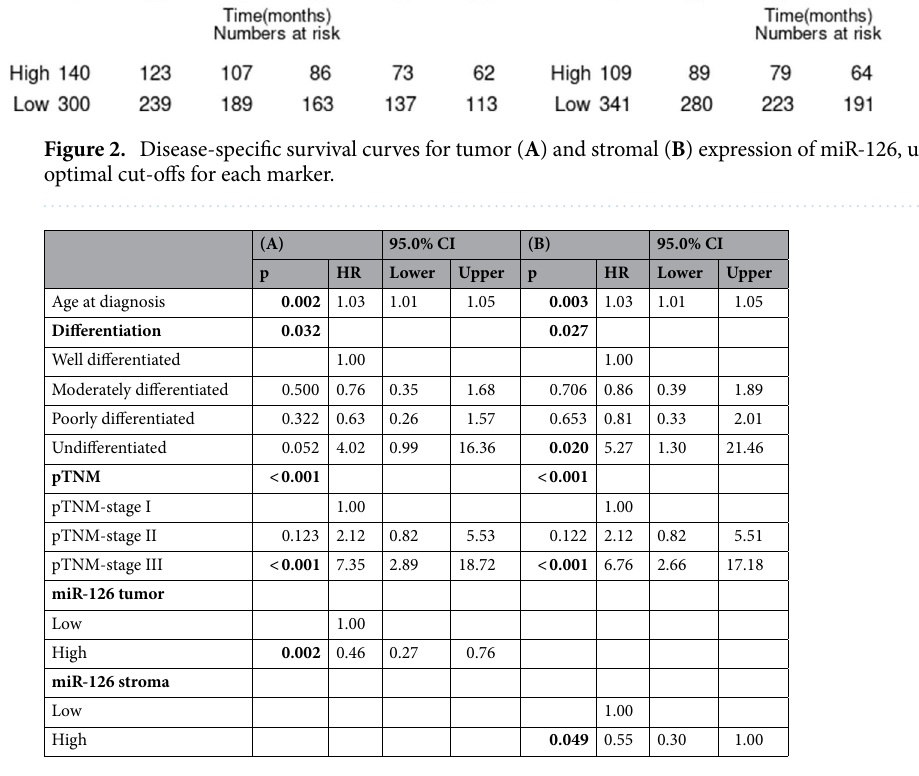
Table 3. Multivariate models for miR-126 in (A) tumor and (B) stroma (cox proportional hazards test, n = 452). Statistically significant results indicated in